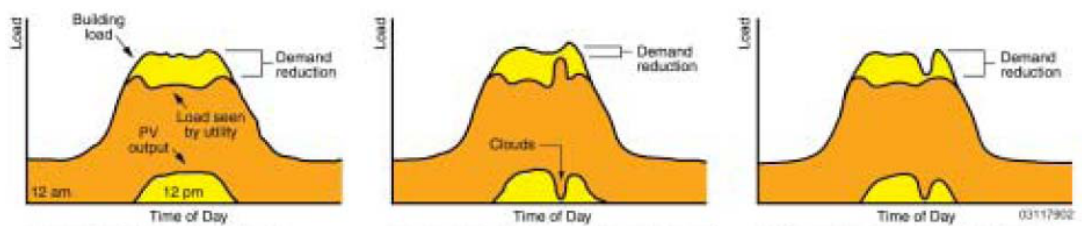
Figure 60. Summer peak load (envelope of curve) and solar peak capacity (yellow) [255].